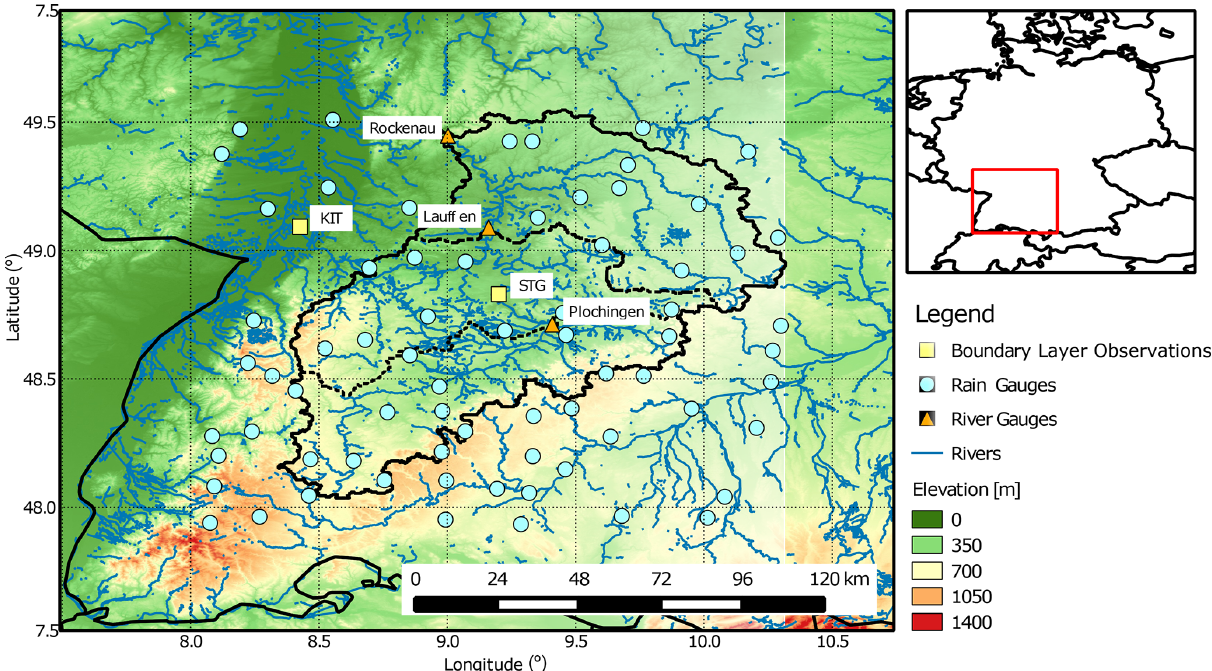
Figure 1. Location of the Neckar catchment within SW